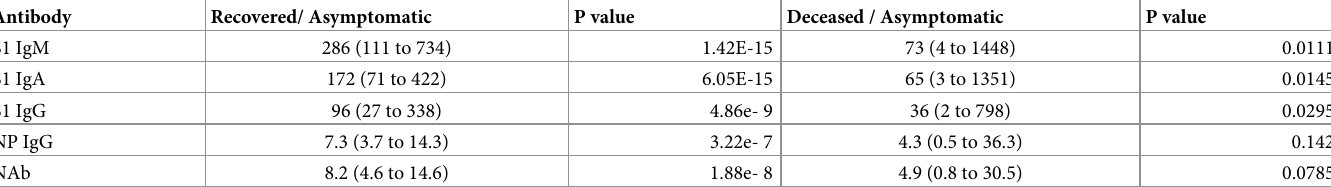
Table 5. Comparison of baseline immune responses for recovered or deceased versus asymptomatic controls.